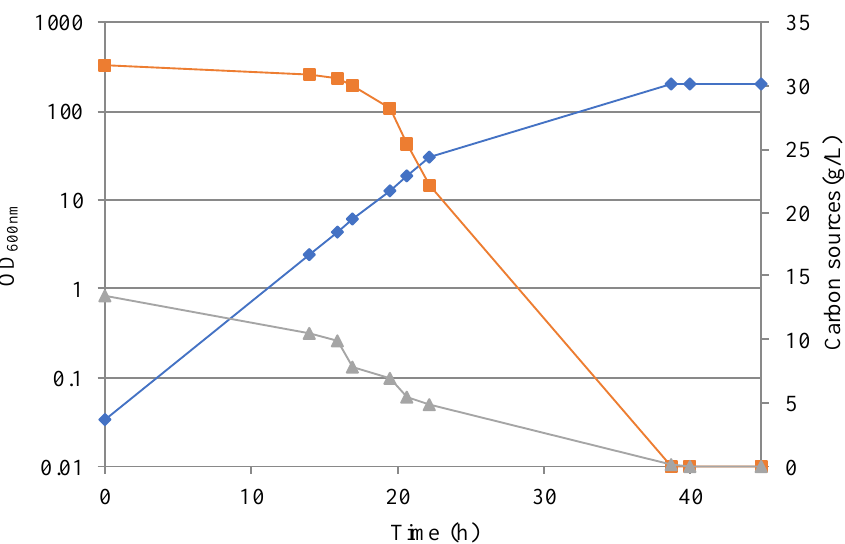
Figure 2. Growth of D. hansenii in industrial-like seawater-based medium (IMSS). Blue: OD 600nm ; orange: residual glucose; grey: residual xylose.